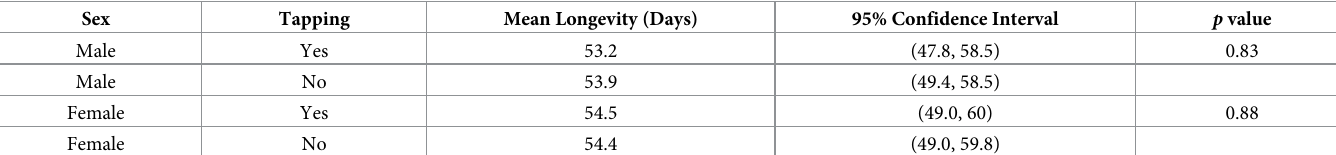
Table 2. Mean longevity from the tapping experiment. The p -value is for a t -test for different mean longevities of same sex treatments. There is no discernible difference in the mean longevity of the flies that were tapped versus those that were not tapped. Mean Longevity